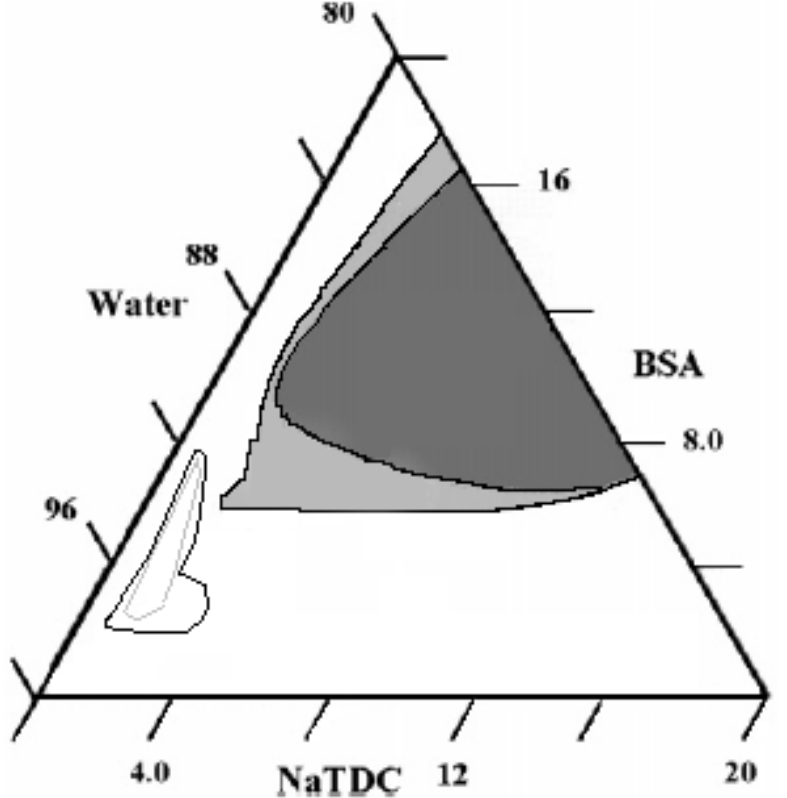
Figure 12. Partial phase diagram of the ternary system water- NaTDC - BSA , at 25.0 °C and pH 6.4. The gel, in dark grey, is essentially elastic at temperatures below 40.0 °C and becomes viscous above that limit. The two-phase region gel + solution is in light grey colour. The dotted lines in the low left side of the figure indicate precipitation when the pH is 5.0, light grey, or 3.0, black colour,